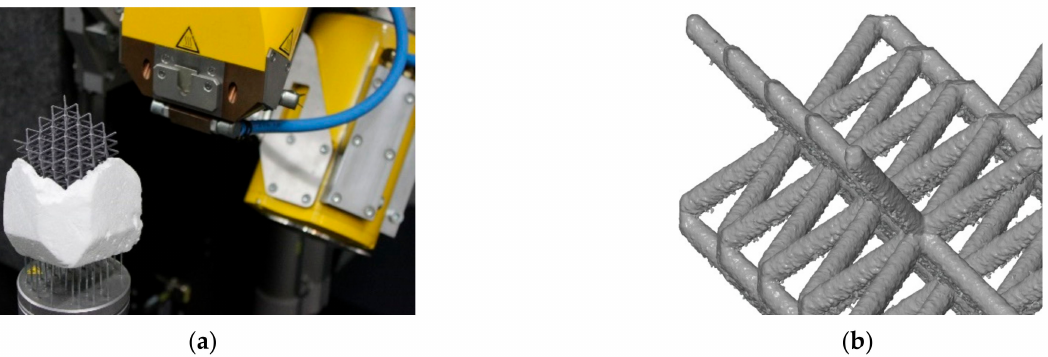
Figure 2. ( a ) µ CT digitization process of one lattice structure specimen. ( b ) Output of the µ CT digitization in the form of the polygonal